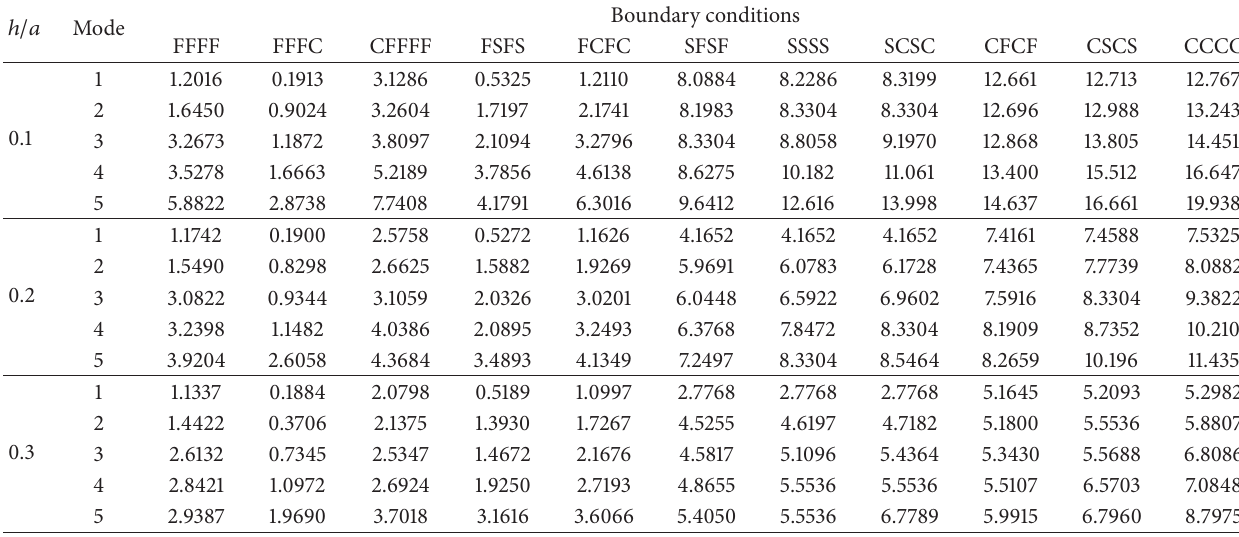
Table 3: The first five frequency parameters Ω = 𝜔𝑎 2 √𝜌ℎ/𝐷 of an orthotropic plate with various boundary conditions and thickness-length ratios ( 𝑎/𝑏 = 1/2